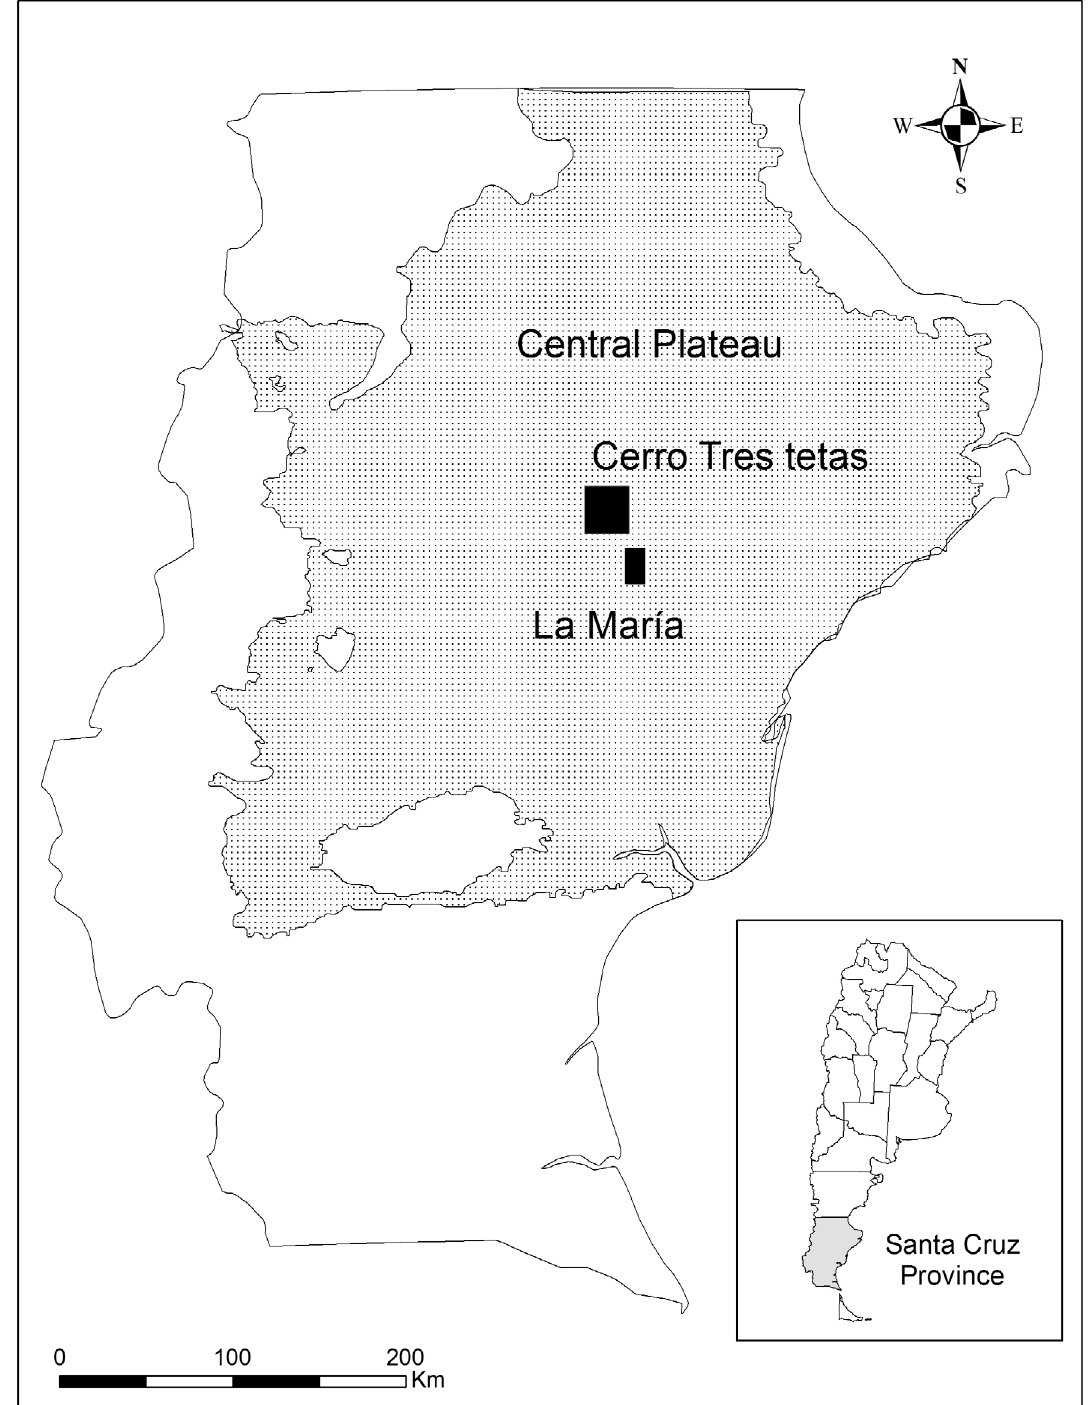
Figure 1. Location of the Central Plateau and La María and Cerro Tres Tetas archaeological